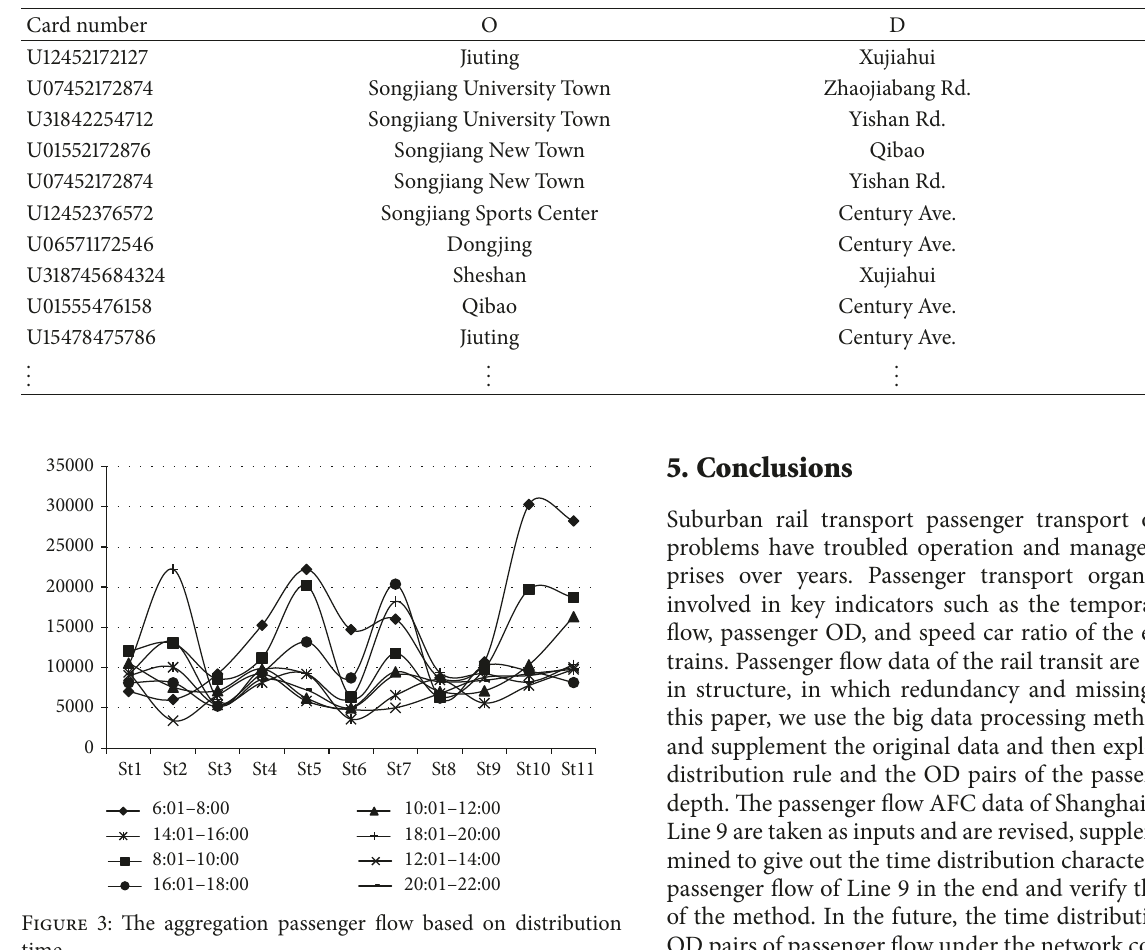
Table 5: The mining of passengers’ travel OD pair rule (upward direction).